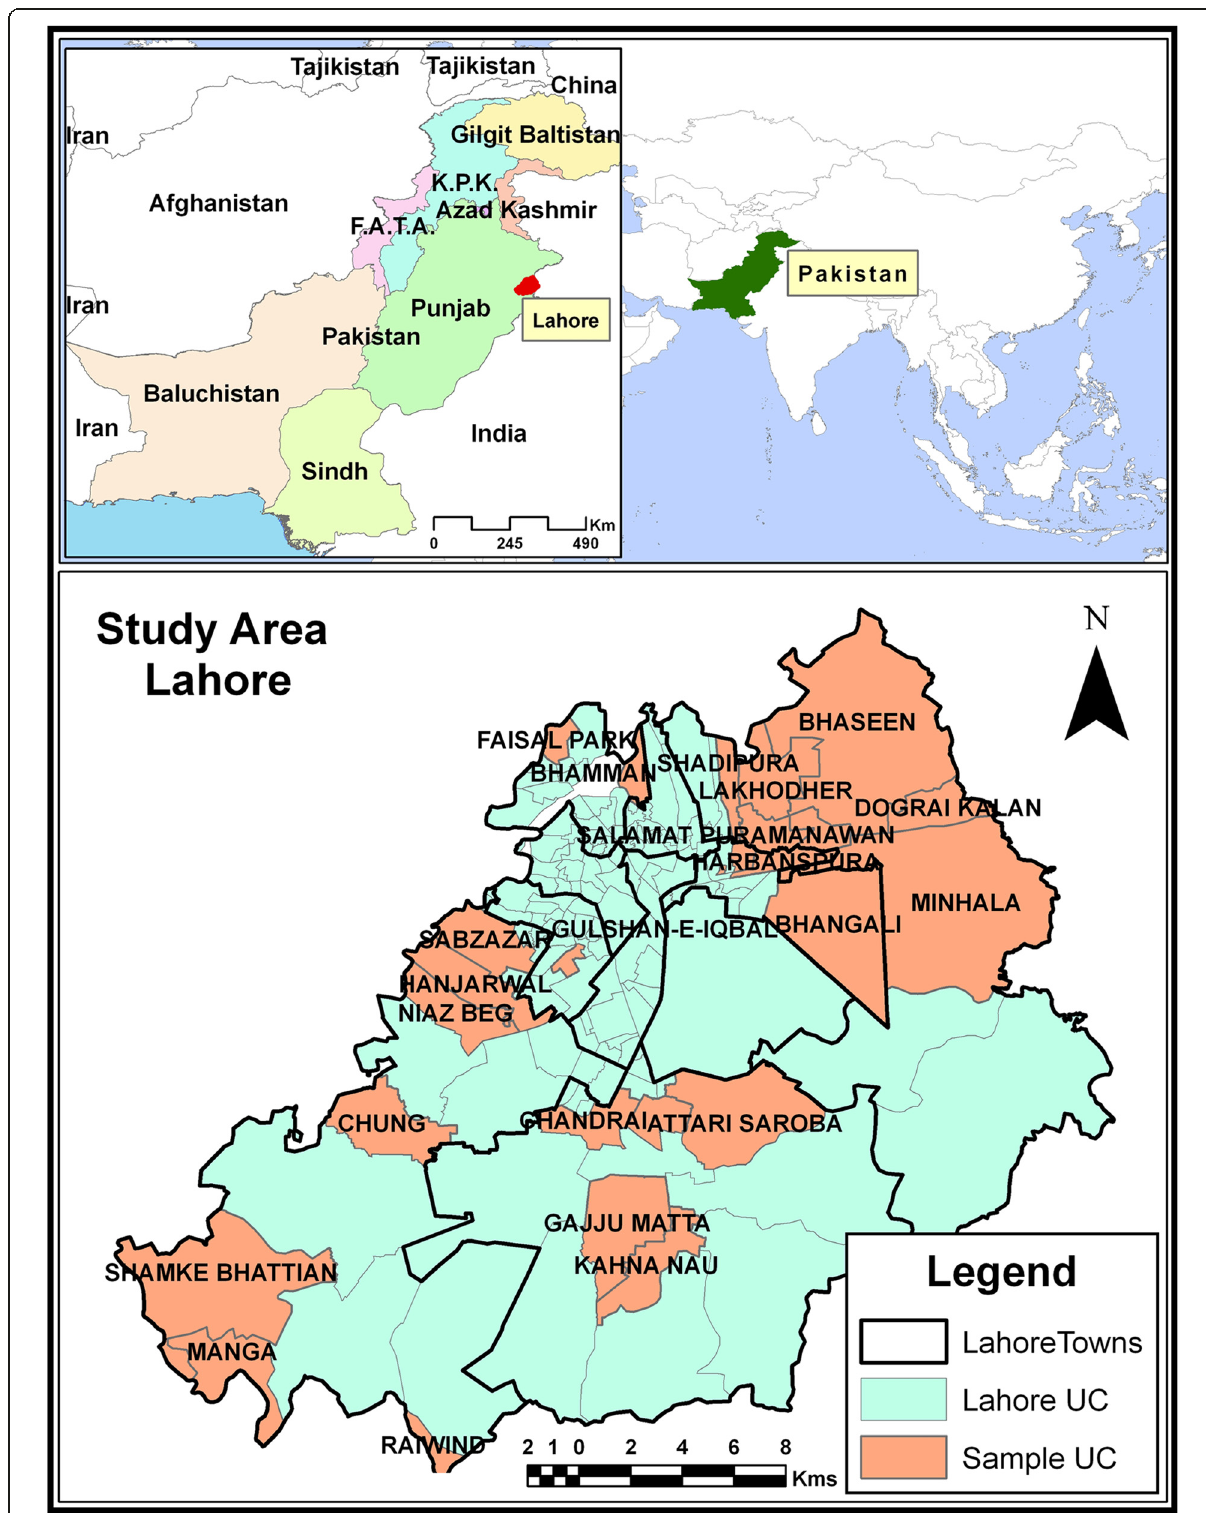
Fig. 1 Location map showing Lahore — the study